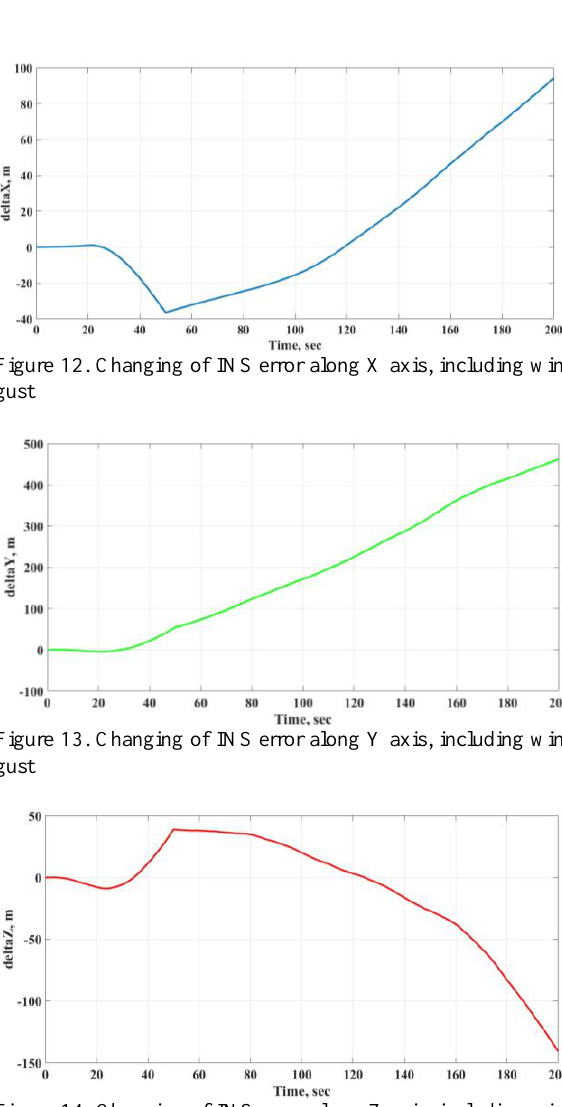
Figure 14. Changing of INS error along Z axis, including wind